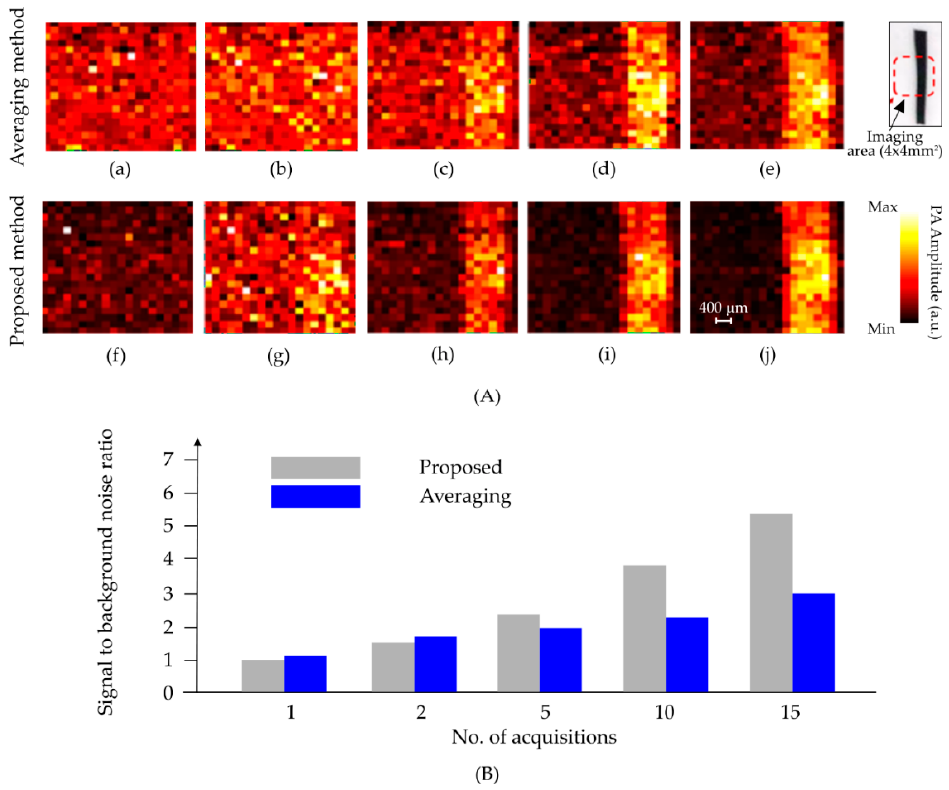
Figure 5. ( A ) Comparison between the averaging method and proposed method for 1 (a, f), 2 (b, g), 5 (c, h), 10 (d, i), and 15 (e, j) signal acquisitions. ( B ) Signal to background ratio comparison between the averaging method and proposed method for 1, 2, 5, 10, and 15 signal acquisitions. Table 1. Comparison between averaging and the proposed method for different numbers of